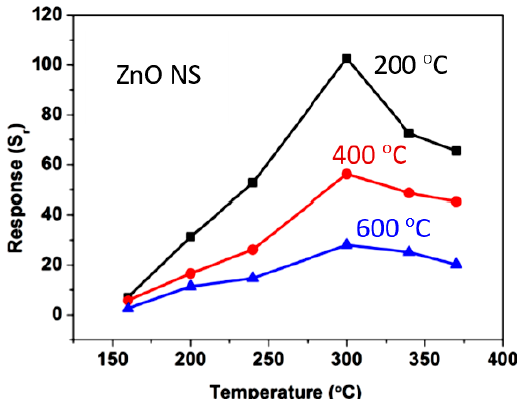
Figure 43. The operating temperature influence on the conductivity response to acetone vapor (200 ppm) of gas sensors based on ZnO nanosheets calcinated at 200, 400, and 600 °C. Reproduced with permission from Li et al. [374]. Copyright 2017: Elsevier.